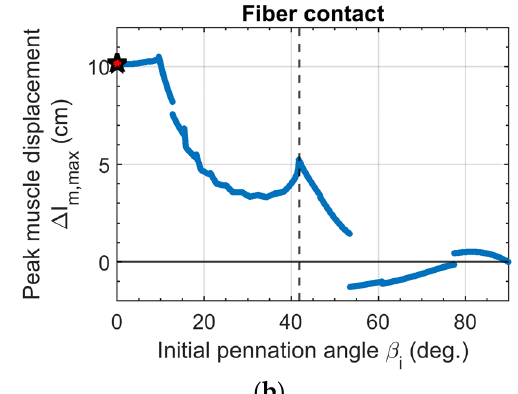
Figure 10. Variation in peak muscle displacement for muscle bundle design with ( a ) pinned boundary condition and ( b ) fiber contact boundary condition. The red star indicates a parallel ( β i = 0 ◦ ) muscle bundle topology, and dashed vertical line indicates the boundary between fiber contraction-limited (left of the line) and fiber rotation-limited (right of line) topologies.